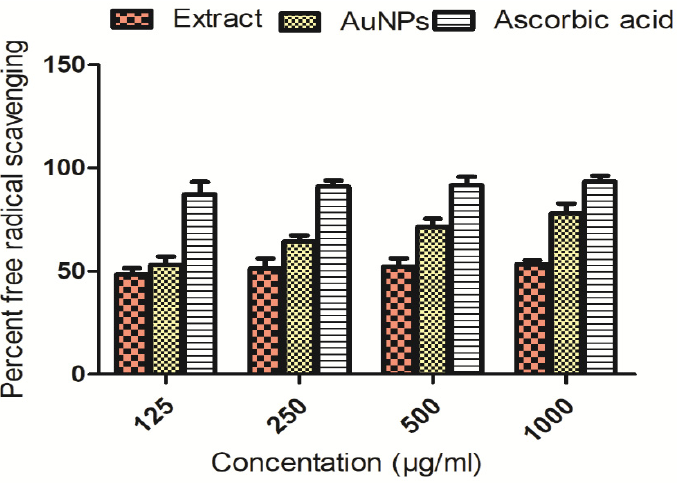
Figure 8. DPPH free radical scavenging effectiveness of extract and its fabricated AuNPs.